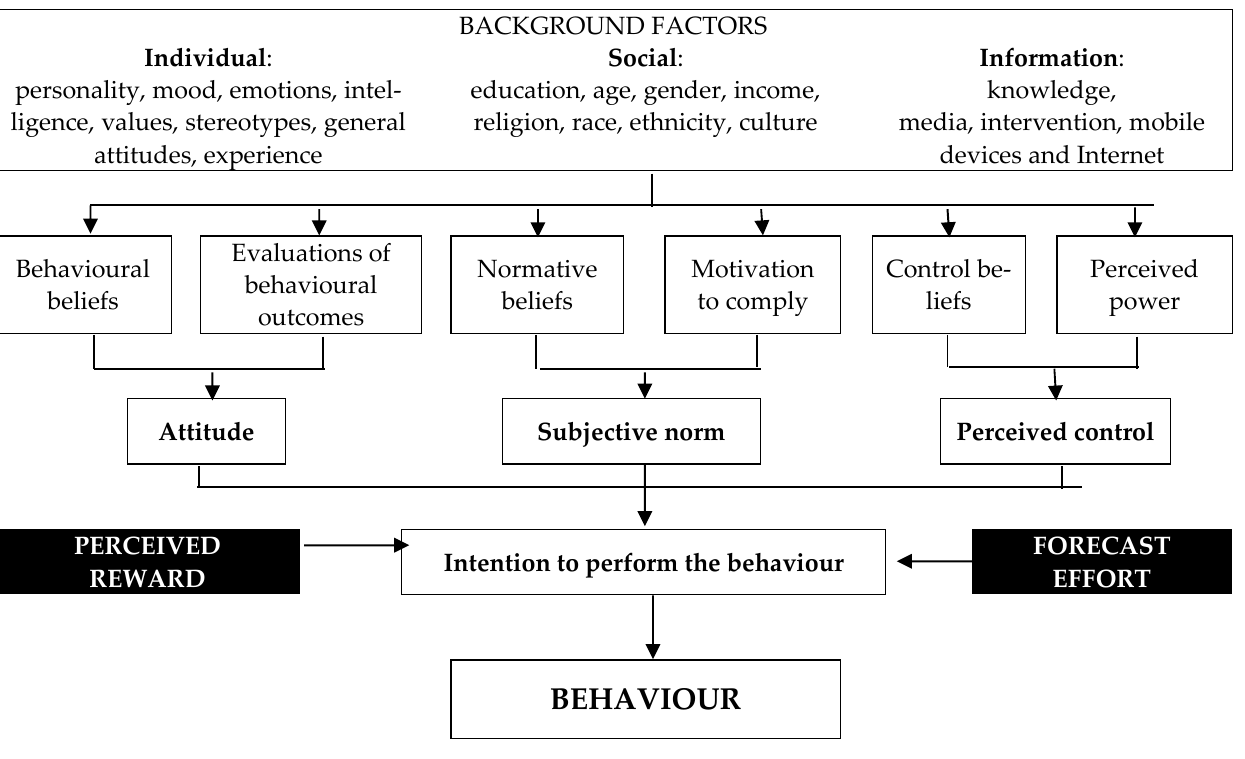
Figure 1. The planned behaviour theory adapted from Ajzen and Fishbein [10].